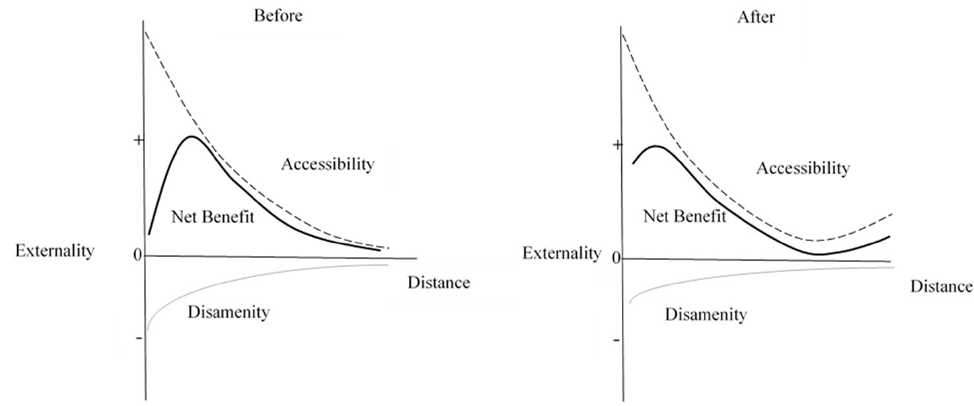
Figure 3. Distance from the city center and externalities.